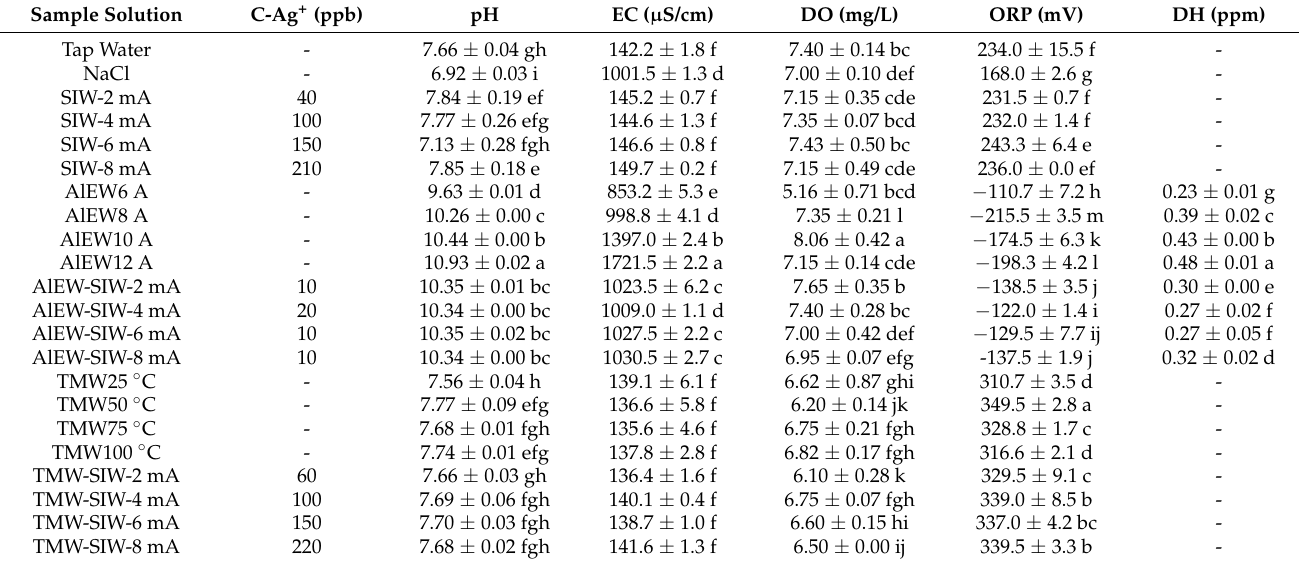
Table 1. Physical and chemical parameters of sample solution used in the present study